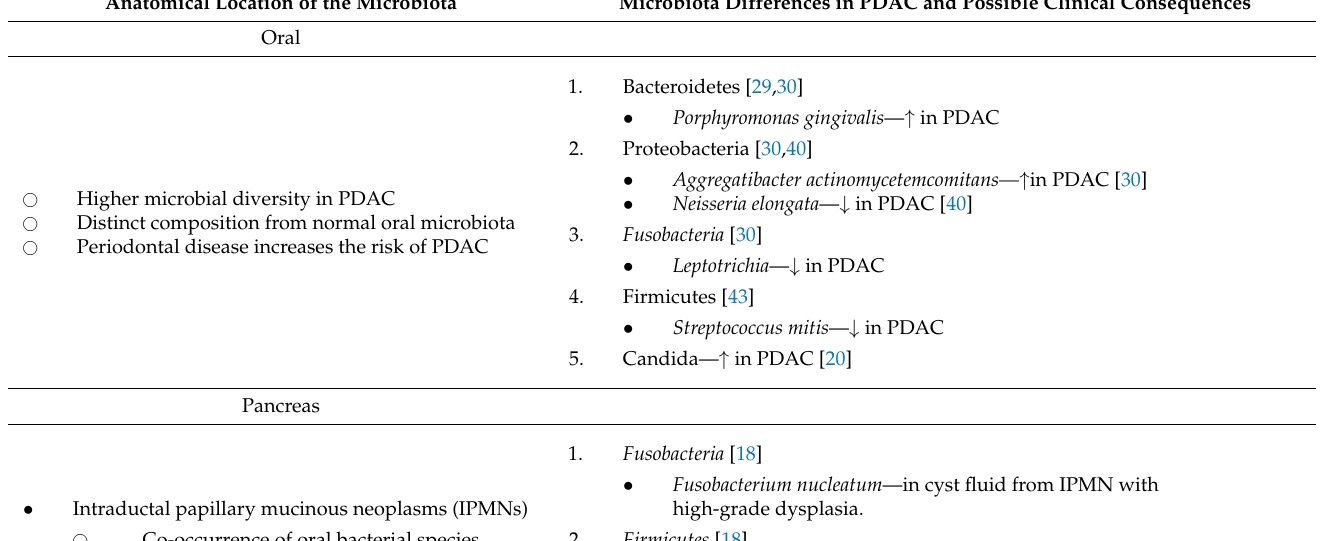
Table 1. Common features of the microbiota differences and their consequences in patients with PDAC and precancerous lesions. Anatomical Location of the